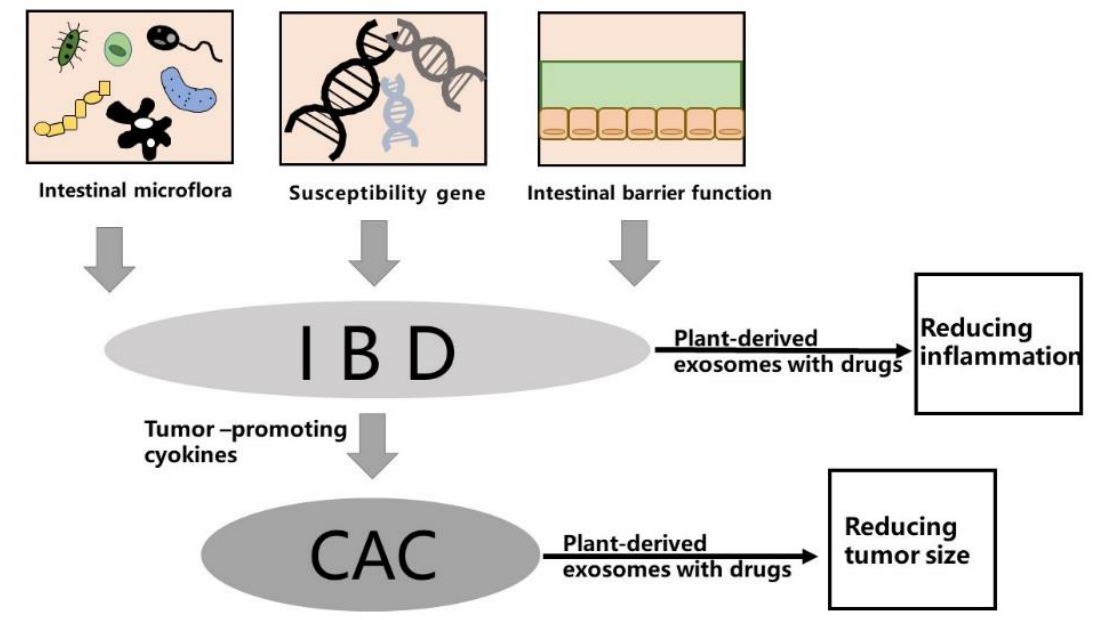
Figure 1. Typical factors for IBD. There are many factors for IBD, among which intestinal microflora, susceptibility gene, and intestinal barrier function are widely recognized. Furthermore, inflammatory intestinal epithelial cells can secrete cytokines that promote tumor growth. Experiments show that IBD and CAC can be effectively treated by plant-derived exosome-loaded drugs.